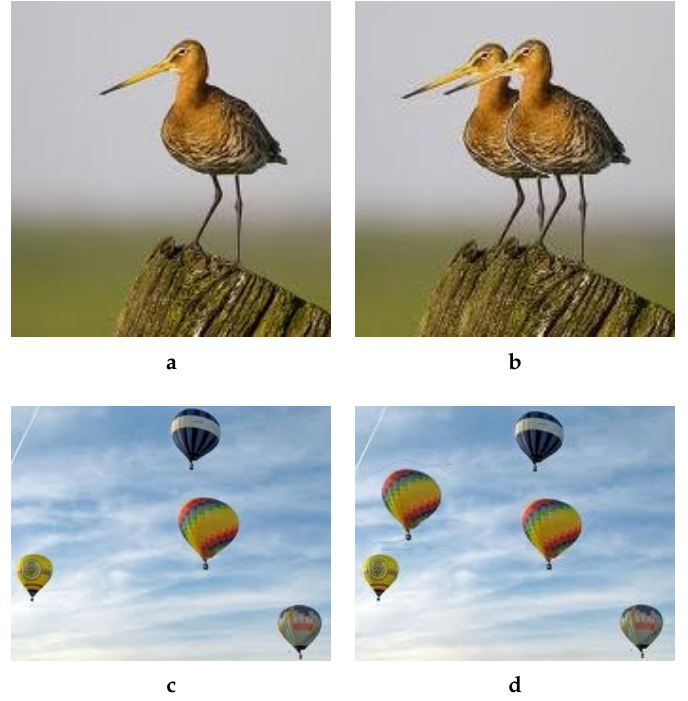
Figure 9. Example Results. ( a ) Original, ( b ) Forged, ( c ) Original (https://upload.wikimedia.org/ wikipedia/commons/e/e9/WIM_2004_balloons.jpg (accessed on 8 December 2021)), ( d )